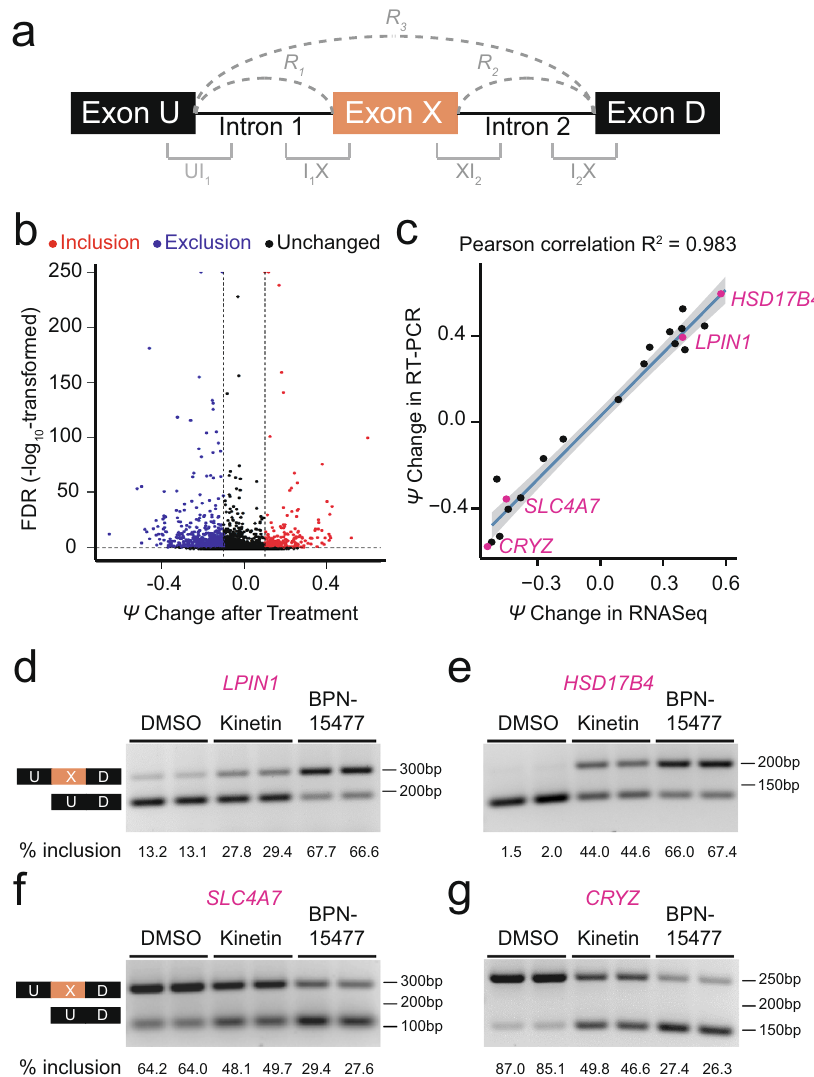
Fig. 2 Transcriptome-wide changes in response to BPN-15477. a Schematic representation of an exon triplet. R 1 , R 2 , and R 3 represent RNASeq reads spanning two adjacent exons. The region marked UI 1 , I 1 X, XI 2 , and I 2 D represent 25 exonic base pairs and 75 intronic base pairs. b Volcano plot showing the ψ changes after treatment with BPN-15477. Each dot represents one of the 161,097 expressed exon triplets in human fi broblasts. The x -axis represents the ψ change after the treatment and the y -axis represents the false discovery rate (FDR) ( − log10 transformed). Red dots represent the exon-triplets with an increase of middle exon inclusion ( Δ ψ ≥ 0.1 and FDR < 0.1) while blue dots represent an increase of middle exon exclusion ( Δ ψ ≤ − 0.1 and FDR < 0.1). Black dots are exon-triplets not responsive to the treatment. The two vertical dashed lines indicate a ψ change of 0.1 and − 0.1 as thresholds for exclusion and inclusion, respectively. The horizontal dashed line indicates an FDR of 0.1. c Independent RT-PCR validation of splicing changes of twenty randomly selected candidates. For each validated exon-triplet, ψ change measured by RNASeq ( x -axis) is plotted against the splicing changes measured by RT-PCR ( y -axis). The R 2 value indicates the coef fi cient of Pearson correlation. The solid line shows the estimated linear regression of the average changes. The gray zone indicates the 95% con fi dence interval for predictions from the estimated linear regression. For each exon-triplet we performed six independent replicates ( n = 6). d – g Representative RT-PCR validations of splicing response of LPIN1 ( d ), HSD17B4 ( e ), SLC4A7 ( f ), and CRYZ ( g ) in treated human fi broblasts. The upper bands indicate the isoform in which the middle exon is included while the lower bands indicate the isoform in which the middle exon is skipped. As expected, BPN-15477 is more potent than kinetin. For each gene in ( d – g ), we independently repeated the experiment six times ( n =